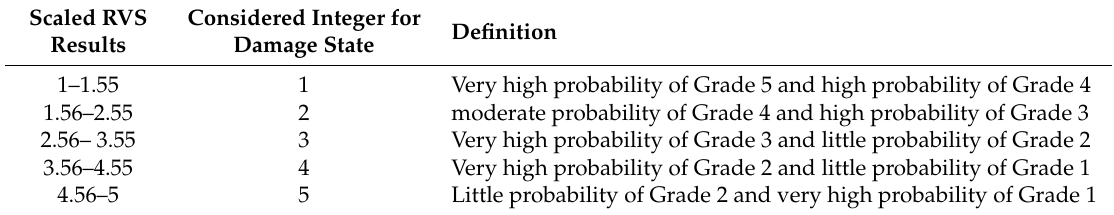
Table 11. Ranges of scaled Rapid Visual Screening (RVS) results with damage state definition [33].